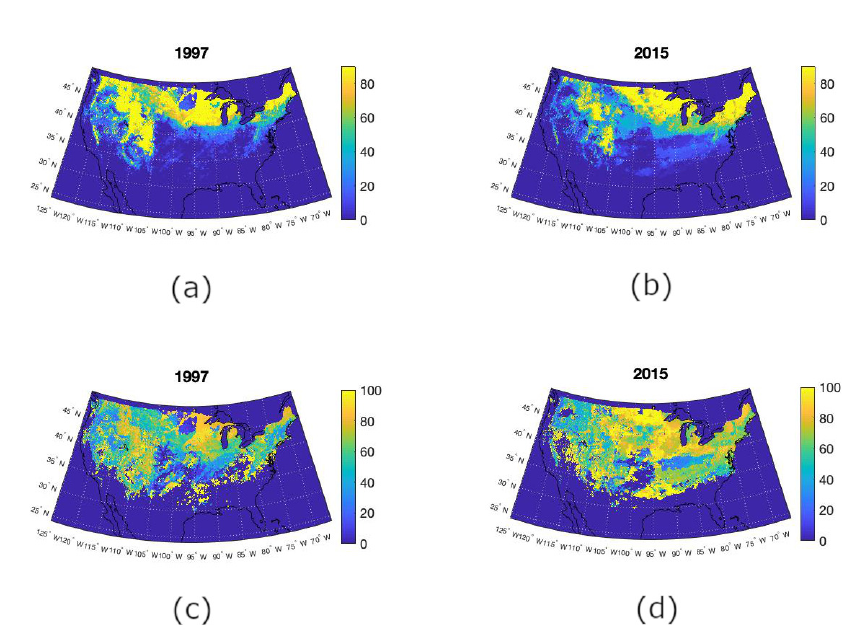
Figure 2. Number of days with dry snow in ( a ) 1997, ( b ) 2015. Percentage of number of days with dry snow to number of days with snow in ( c ) 1997 and ( d )